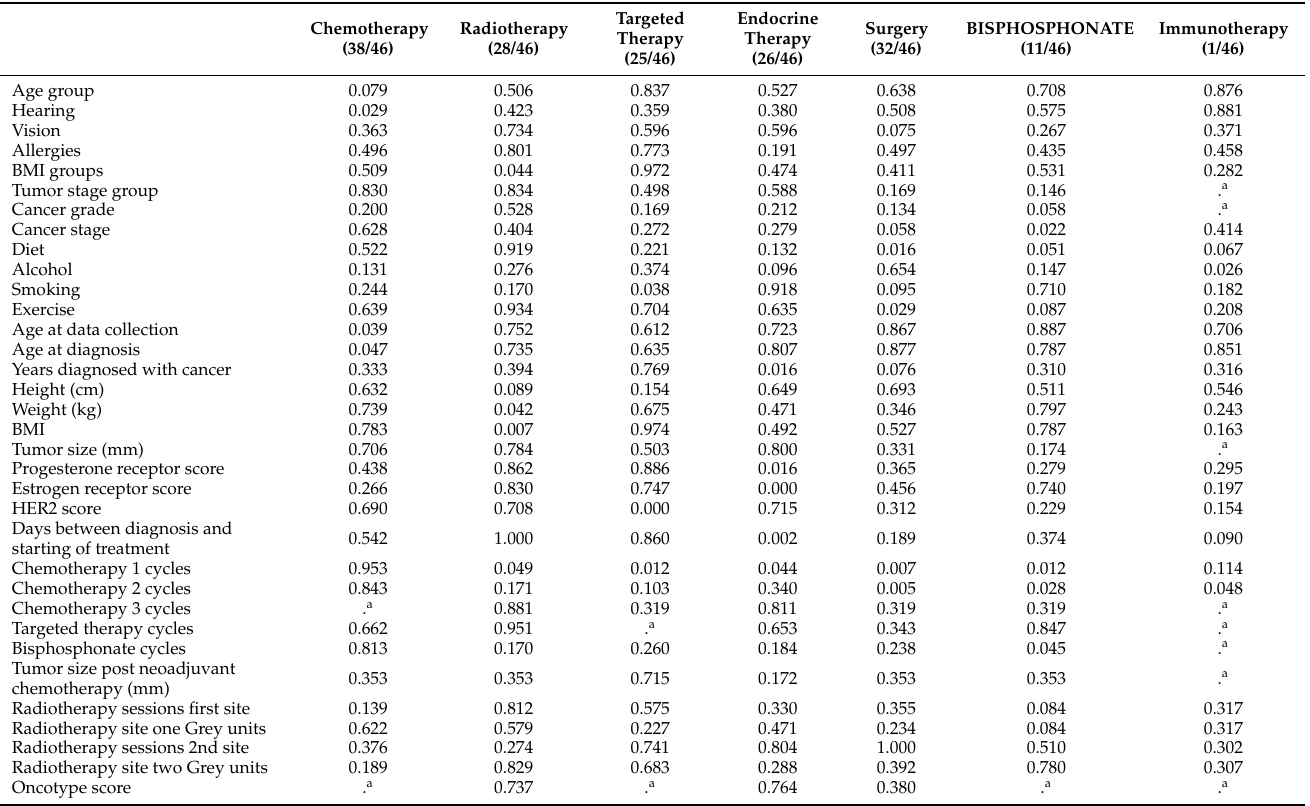
Table 2. Variables used in the analysis of different treatment lines for breast